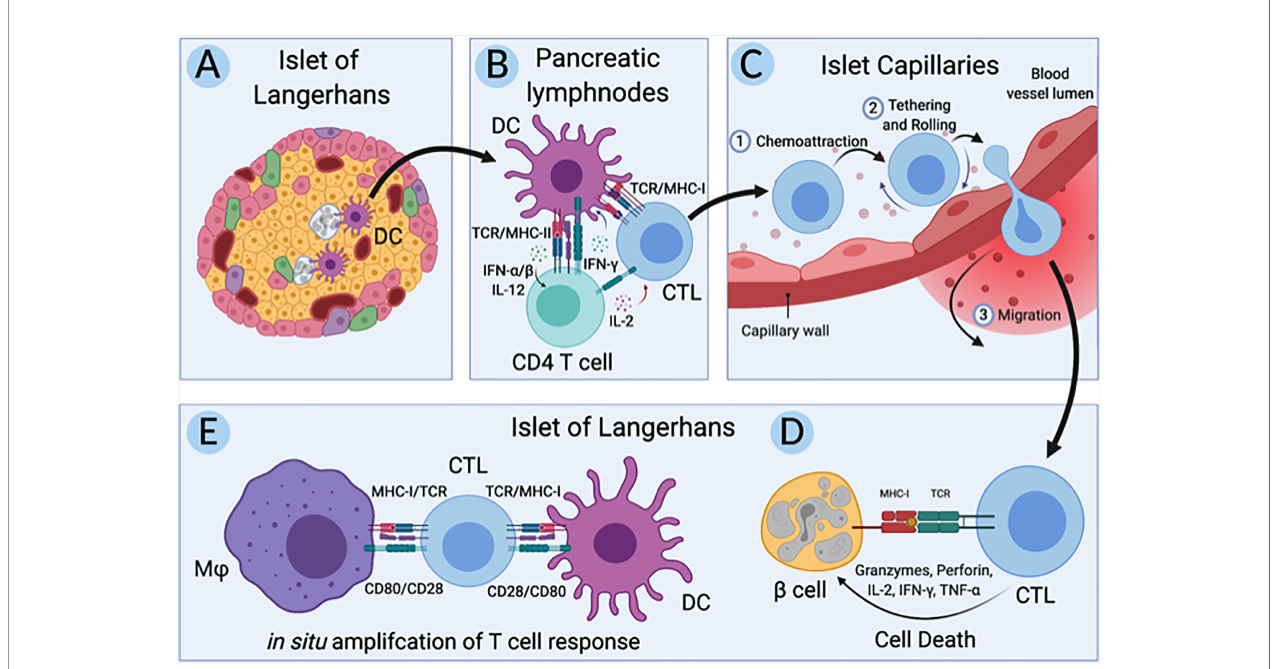
FIGURE 1 | Key cellular interactions involved in pathogenesis of T1D in humans. (A) First dendritic cells (DC) uptake antigen from dead, dying, and stressed b -cells in the islets of Langerhans in individuals at risk for type 1 diabetes (T1D). (B) Second, these b -cell-antigen-loaded DC migrate to the pancreatic lymph nodes where they present b -cell antigen to autoreactive CD4 + and CD8 + T cells, initiating an adaptive immune response. (C) Third, these autoreactive CD8 + T cells, also called cytotoxic T lymphocytes (CTLs), migrate back to the pancreas and undergo transendothelial migration across the endothelium lining capillaries that supply the islets of Langerhans. (D) Fourth, these CTLs directly target and lyse b -cells while (E) resident and in fi ltrating macrophages and DC amplify the CTL response in situ . Created with